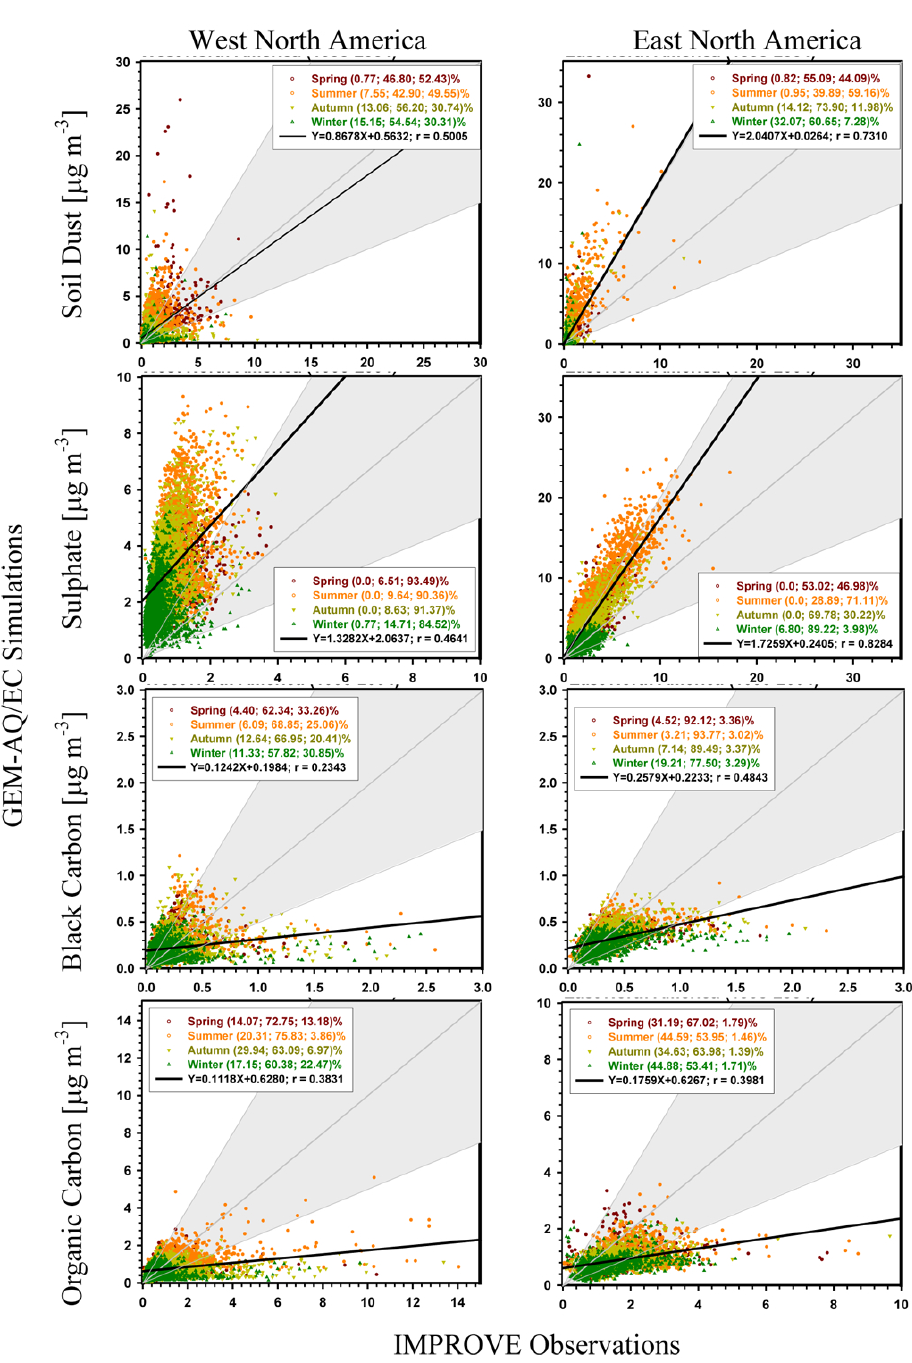
Fig. 9. Comparisons of model predicted concentrations of four major aerosol species in North America with IMPROVE network observations. West and East North Americas are compared separately. Legend explanations are given the same as in Fig.